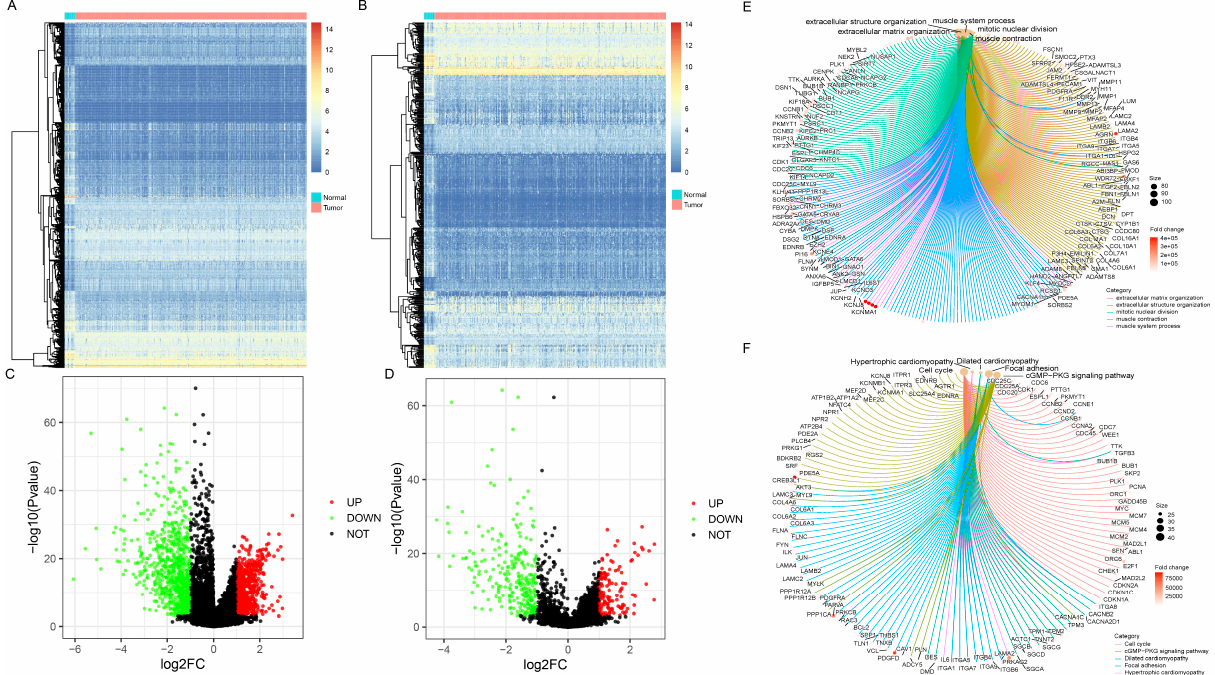
Figure 1. Differentially-expressed gene screening and enrichment analysis of immune-related genes (IRGs). Heatmaps represented differentially expressed genes or IRGs between BC and normal sam- ples, respectively ( A , B ). Green dots in volcano plot demonstrated down-regulated genes or IRGs, and red dots demonstrated up-regulated genes or IRGs, respectively ( C , D ). The enrichment analysis of biological processes and pathways were shown via Gene Ontology (GO) and Kyoto Encyclopedia of Genes and Genomes (KEGG) ( E , F